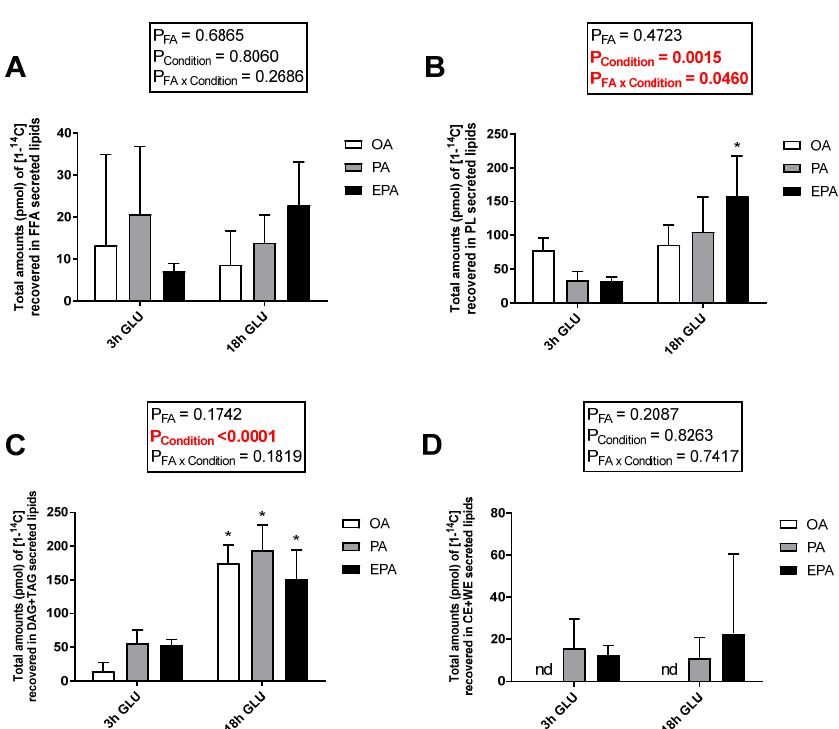
Figure 7. Distribution between free fatty acids (FFA) ( A ), phospholipids (PL) ( B ), mono and diacylglycerol (MDG) and triglycerides (TAG) ( C ), and cholesteryl esters and wax esters (CE + WE) ( D ) produced from [1- 14 C] PA in the media from mature Atlantic salmon adipocytes incubated with oleic, palmitic, or eicosapentaenoic acid for 72 h and serum-deprived in the presence of glucagon thereafter for 3 (3 h GLU) and 18 h (18 h GLU). Data are shown as mean ± SEM ( n = 3). Results are compared by two-way ANOVA using the fatty acid tested (OA, PA, and EPA) and the experimental condition (3 h GLU and 18 h GLU) as factors. Asterisks (*) indicate significant differences between conditions ( p < 0.05; Sidak’s test). OA = oleic acid, PA = palmitic acid, and EPA = eicosapentaenoic acid.